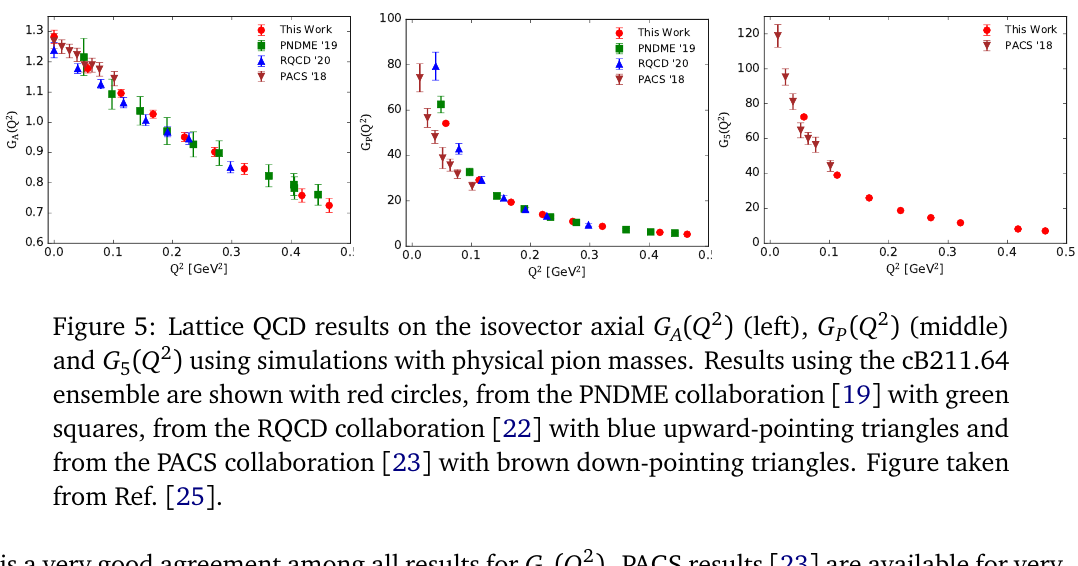
Figure 5: Lattice QCD results on the isovector axial G ( Q 2 ) using simulations with physical pion masses. Results using the cB211.64 and G 5 ensemble are shown with red circles, from the PNDME collaboration [ 19 ] with green squares, from the RQCD collaboration [ 22 ] with blue upward-pointing triangles and from the PACS collaboration [ 23 ] with brown down-pointing triangles. Figure taken from Ref. [ 25 ]